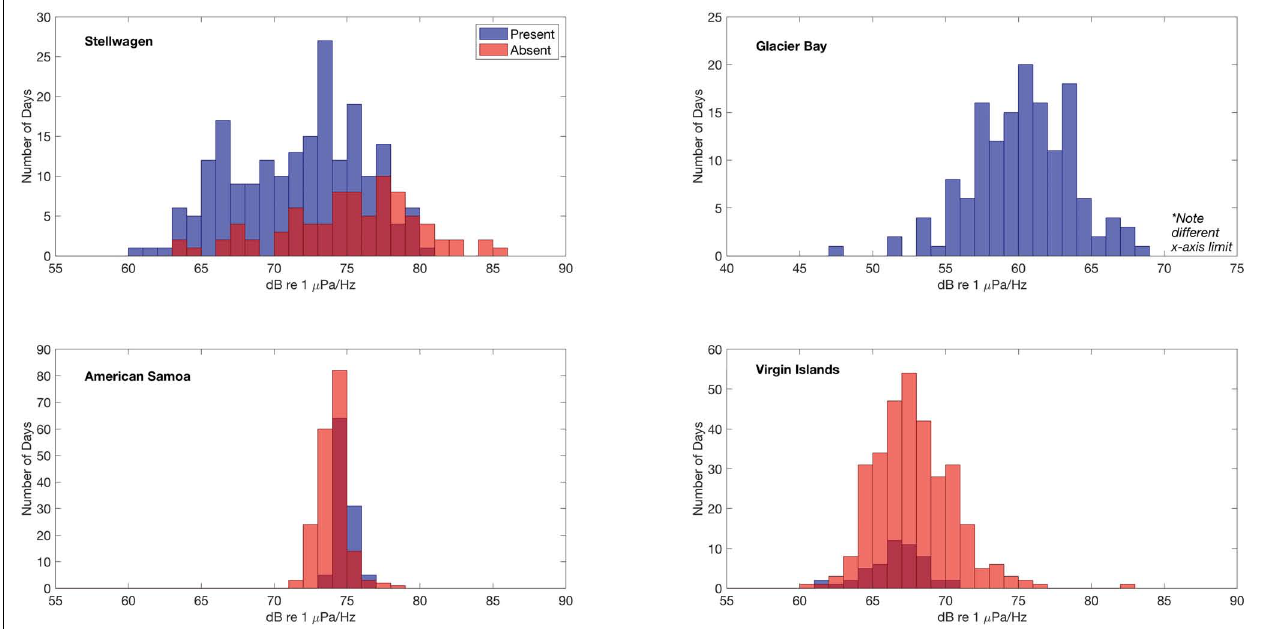
FIGURE 6 | Relationship between the distribution of daily median 500 Hz power spectral density sound levels (dB re 1 µ Pa 2 /Hz) and detection of humpback whale vocalizations at each site. Histograms of sound levels (1 dB bin width) are plotted for two conditions, when humpback whale vocalizations are present (blue) or absent (red). In Glacier Bay, humpback whale vocalizations were detected on all days and thus no absent (red) condition is